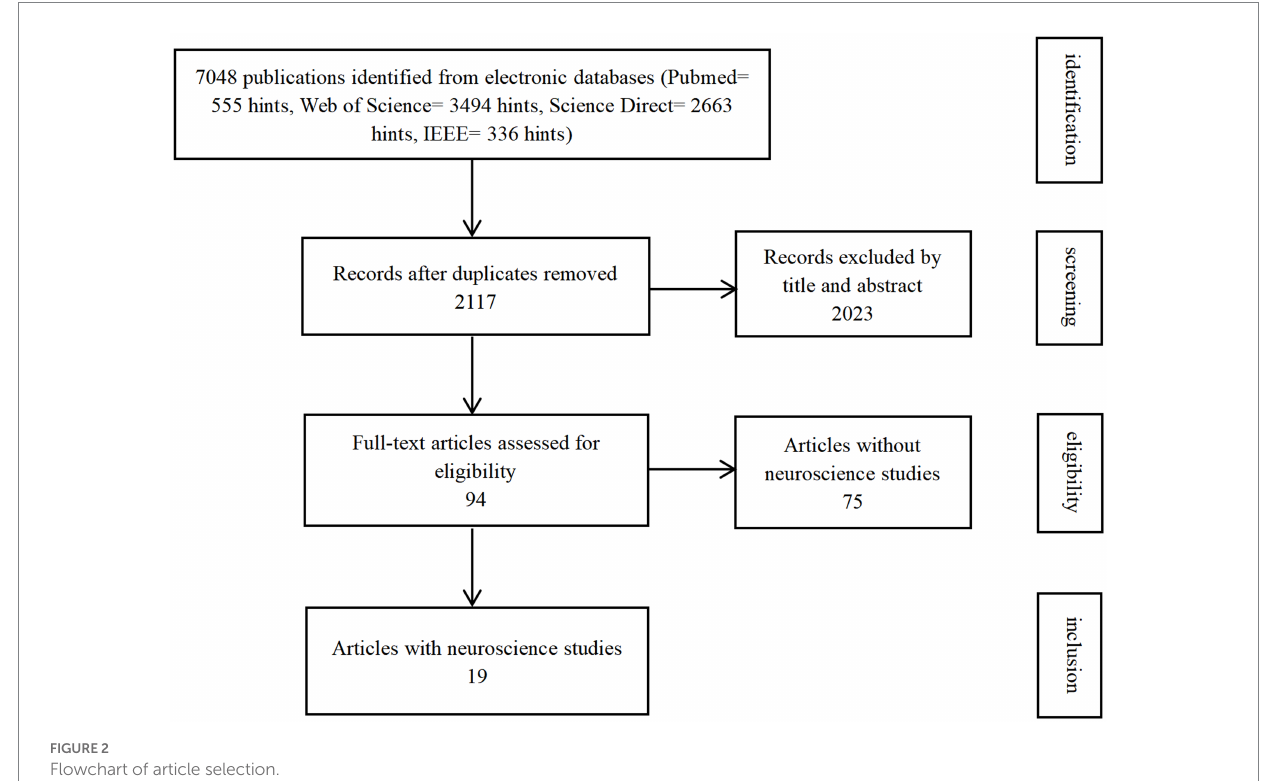
FIGURE 2 Flowchart of article